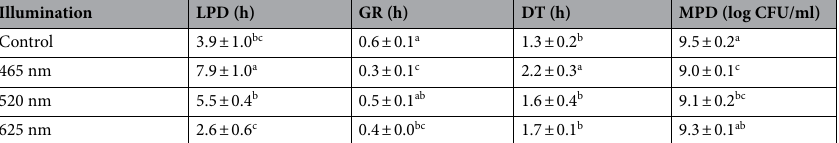
Table 2. Growth parameters of non- and LED-illuminated E. coli O157:H7 in TSB at 25 °C. Different letters for the same column indicate significant difference ( P < 0.05) difference. LPD lag phase duration, GR specific growth rate, DT doubling time, MPD maximum population